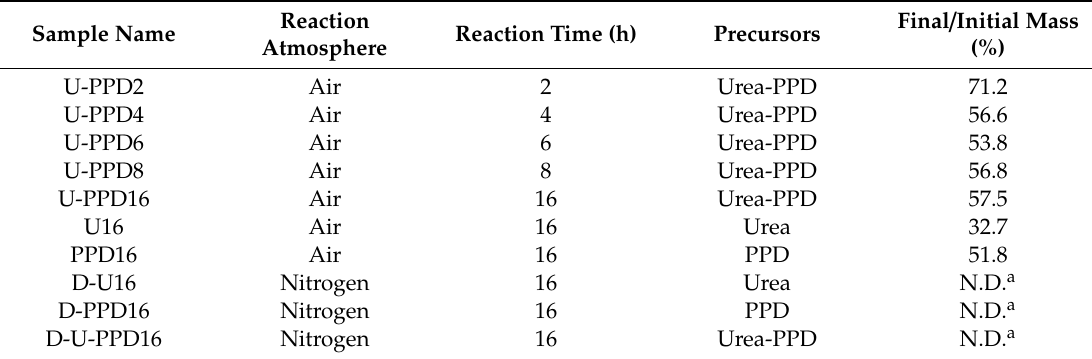
Table 1. Hydrothermal reaction condition for producing urea and PPD derived fluorophores. 100 mg urea and 100 mg PPD in 25 mL water were placed in an autoclave reactor. The reaction time was kept between 2 h and 16 h. The final mass was divided by the initial total mass of precursors to calculate the percentage of obtained mass. a Not